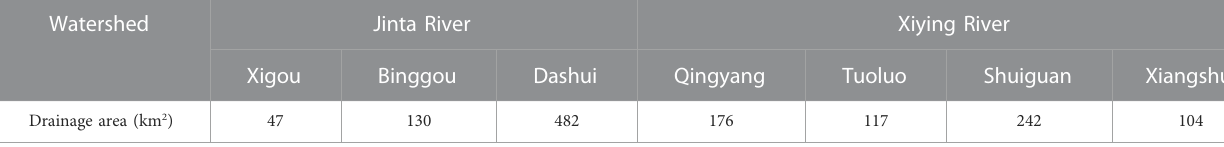
TABLE 2 Drainage area of some tributaries of the Jinta and Xiying Rivers. Watershed